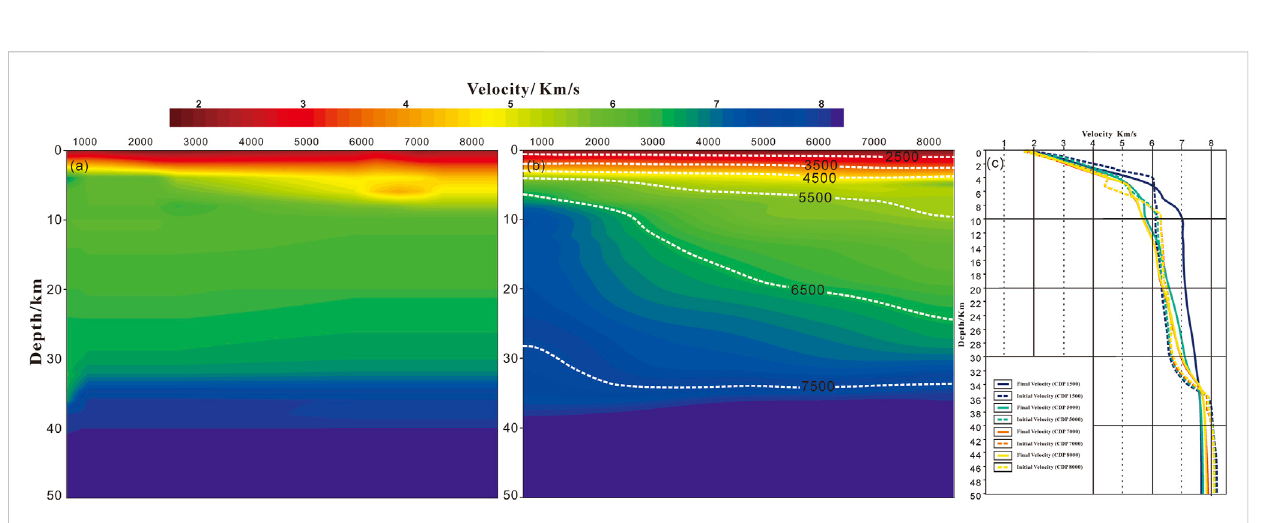
FIGURE 4 The velocity model in the depth domain. (A) The initial interval velocity model, in which the deep part velocity is from wide-angle re fl ection/ refraction velocity. (B) The fi nal internal velocity model of PSDM. (C) 1-D velocity for the initial velocity (A) and fi nal velocity (B) at CDP 1500, CDP 5000, CDP 7000, CDP